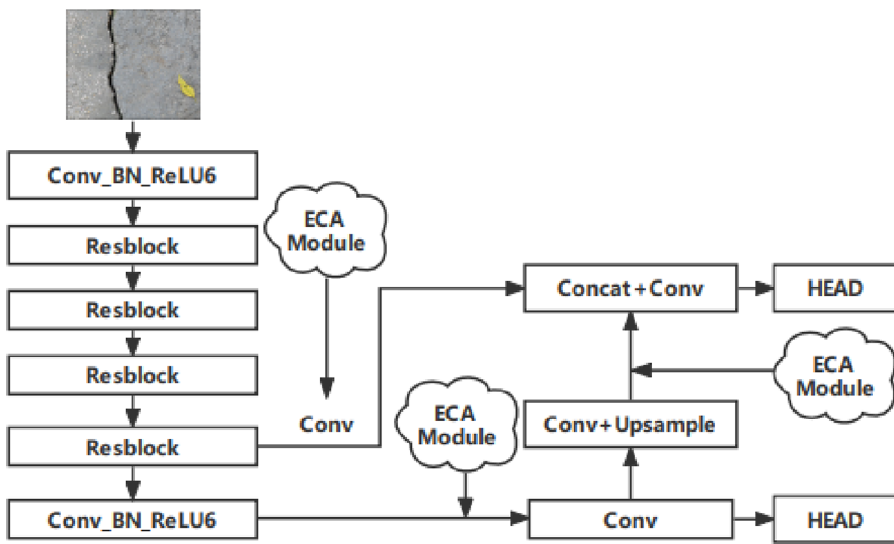
Fig. 6 Network architecture of proposed bridge crack detection